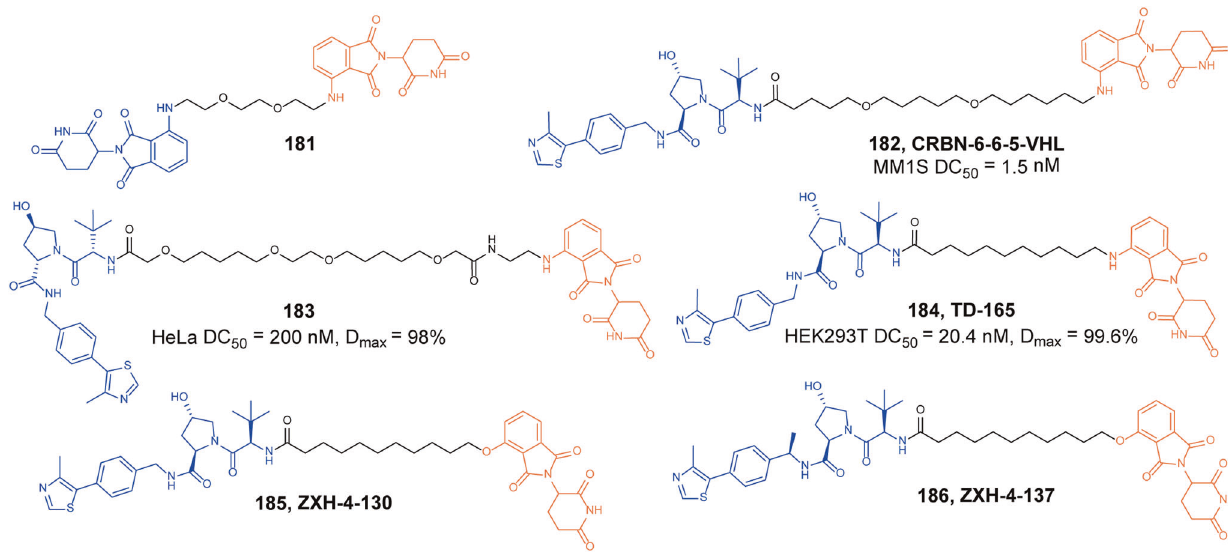
Fig. 49 The representative PROTACs targeting